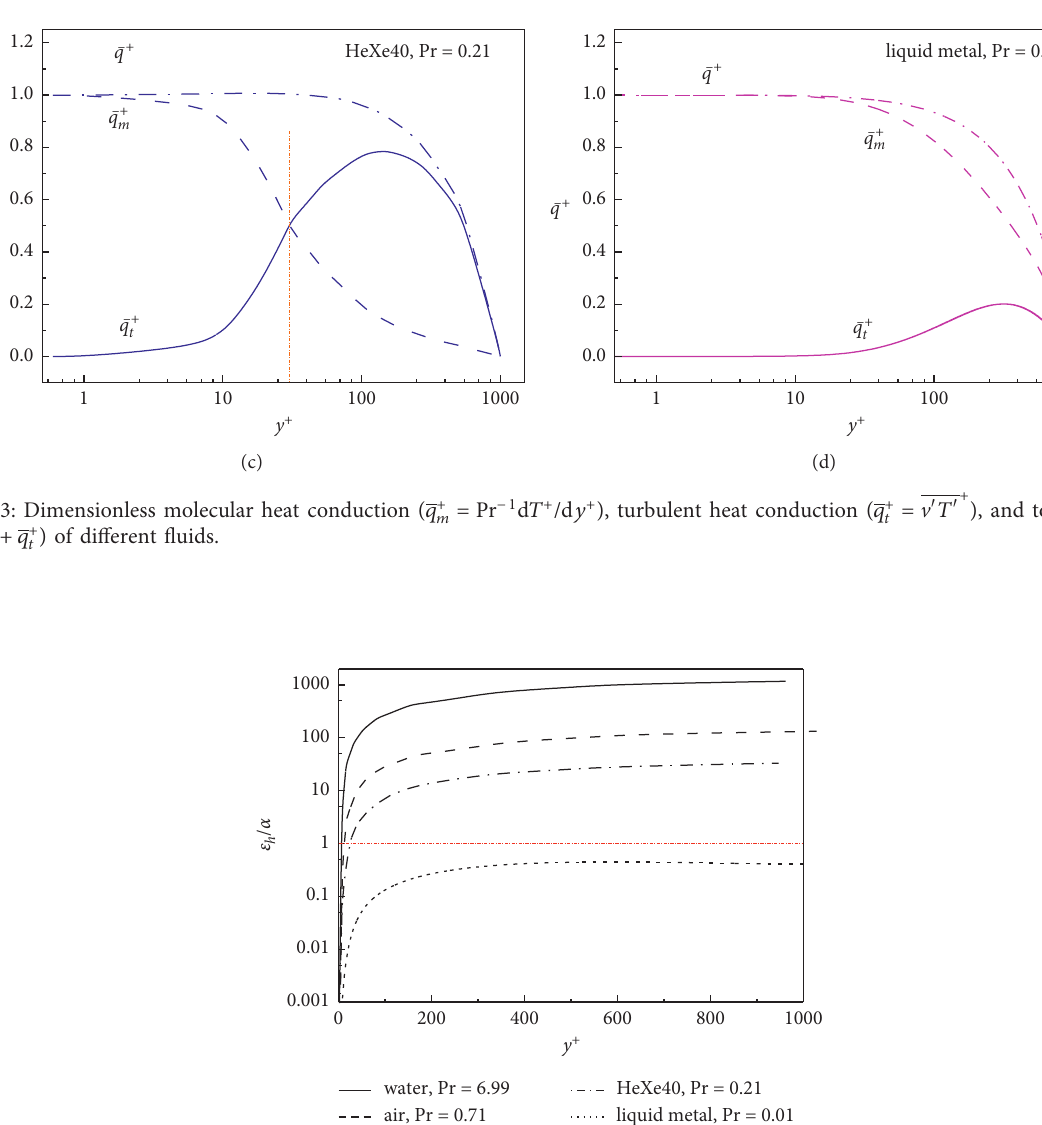
Figure 14: Variation in turbulent heat diffusivity ratio of different